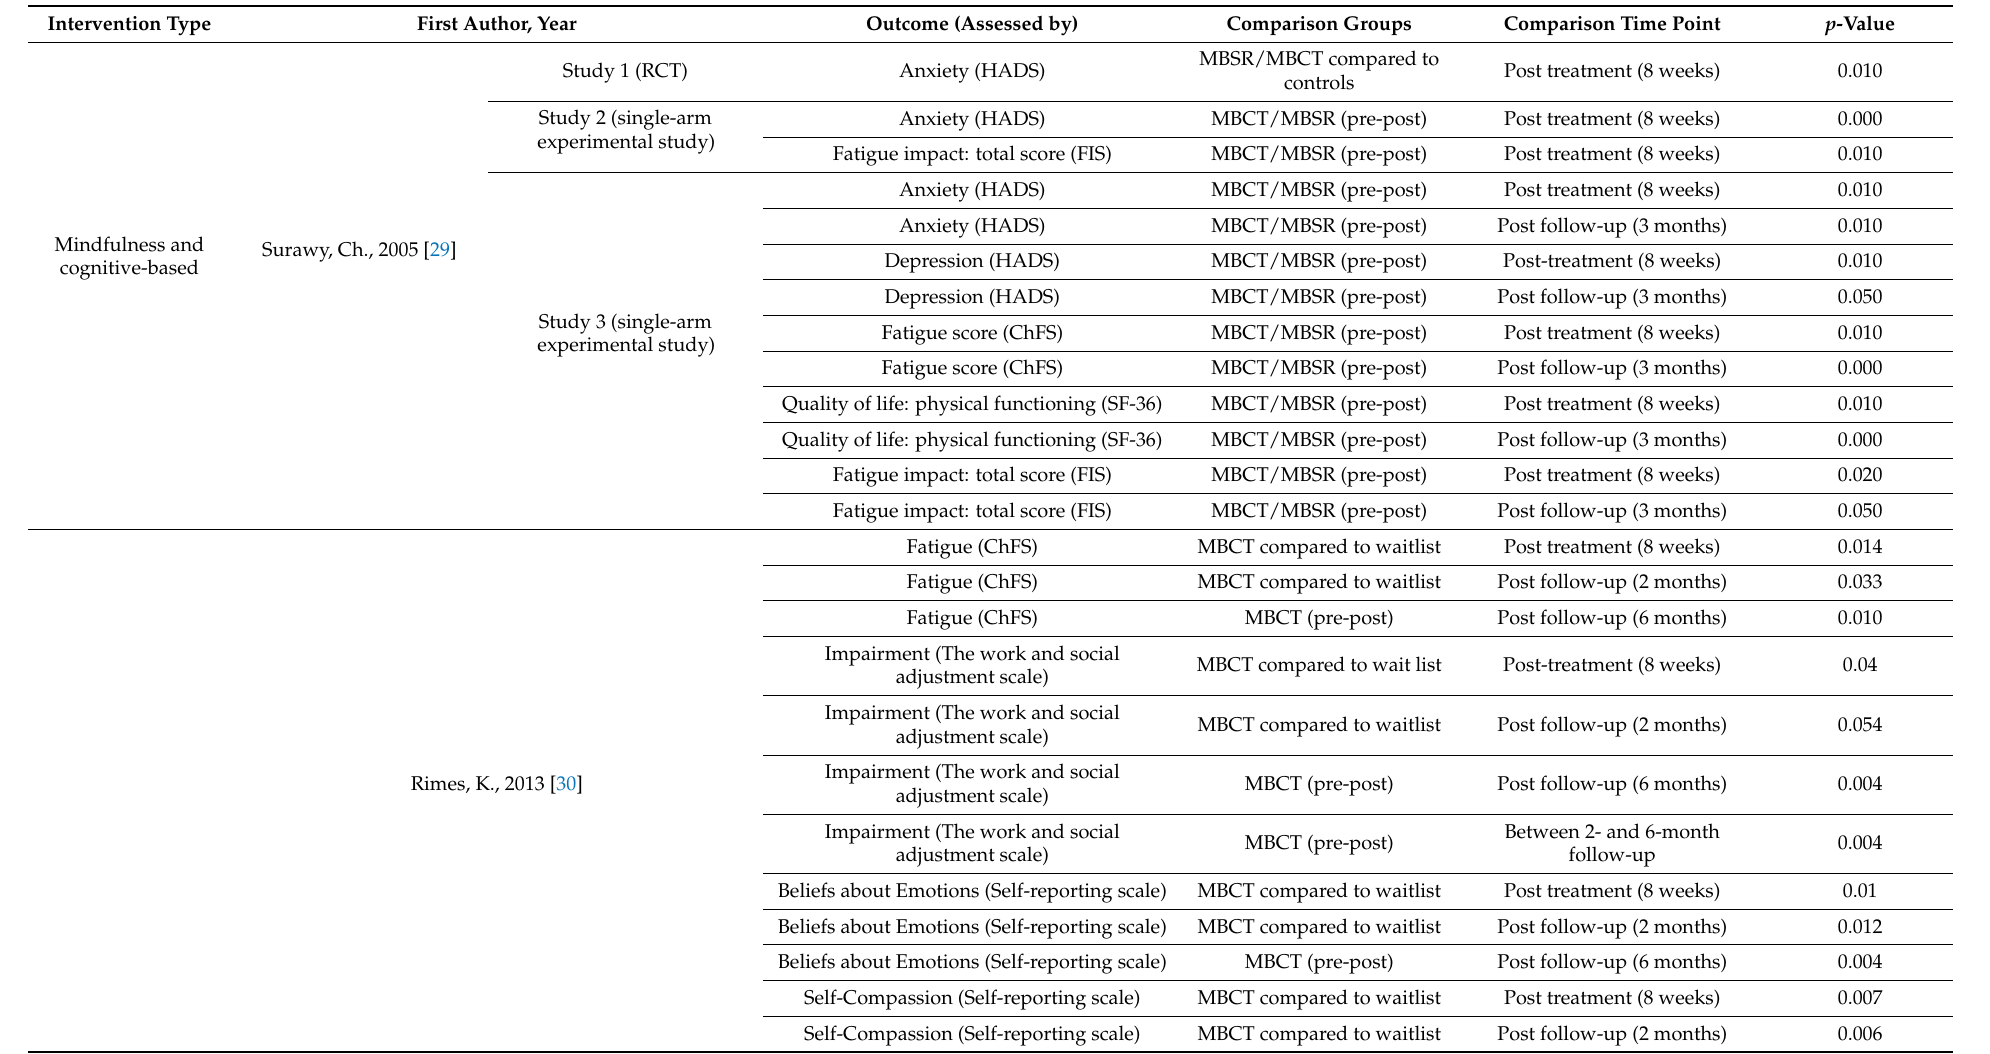
Table 4. Significant outcomes in the included studies using Oxford criteria for diagnosing